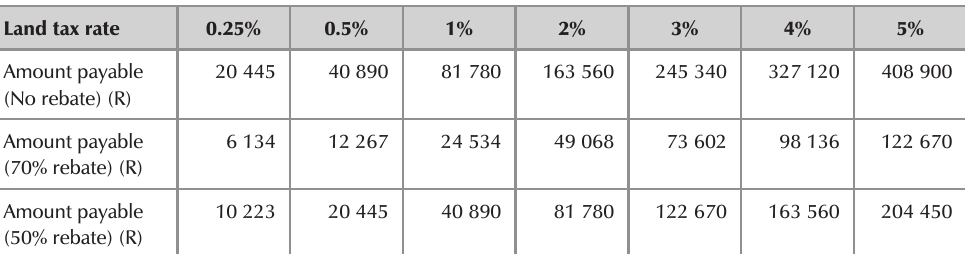
Annual land tax payable with and without a rebate: Case study